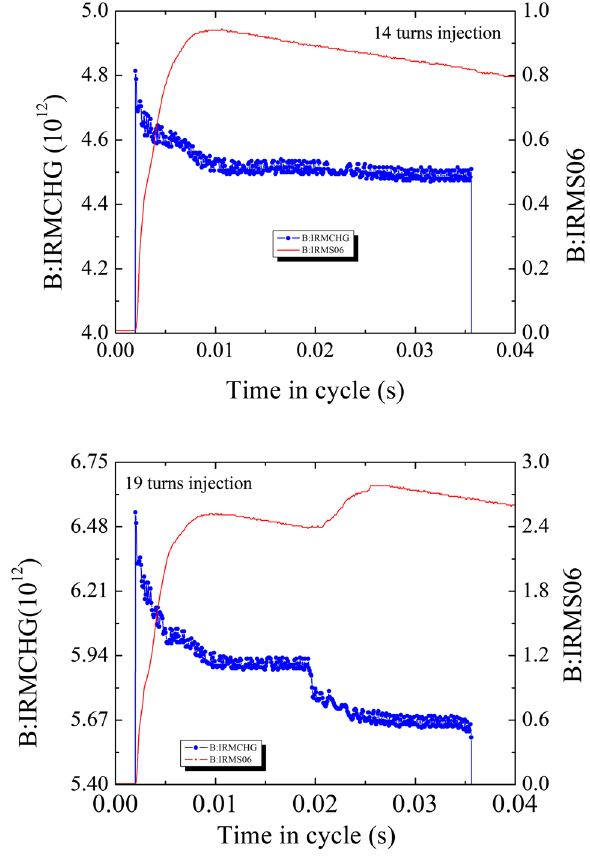
FIG. 4. Booster beam losses in the acceleration cycle: (top) the BCHG0 intensity monitor signal (blue, left axis) and the S06 beam loss monitor (BLM) readings (red, right axis) for nominal operational 14 turns injection intensity; (bottom) the same for higher intensity 19 turns